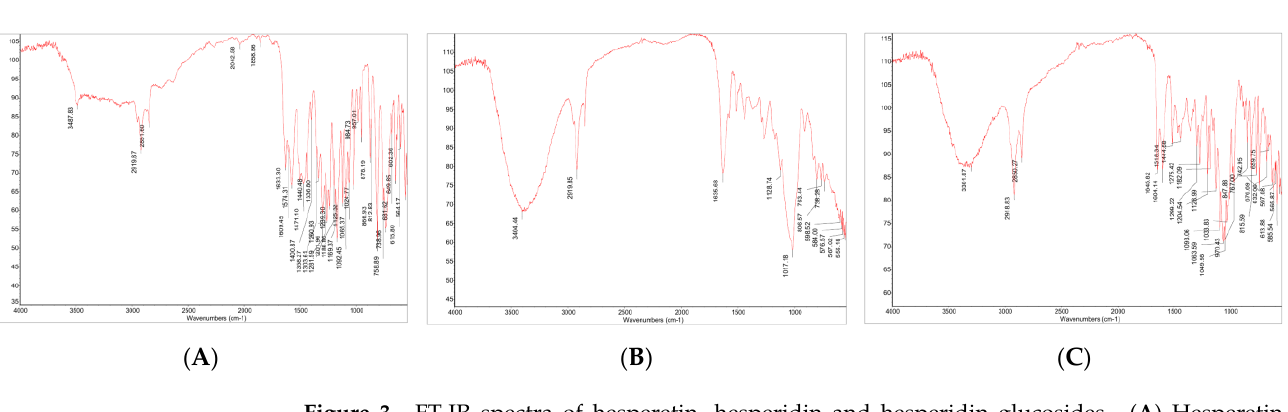
Figure 2. HPLC profiles of hesperidin glucosides synthesized during enzymatic transglycosylation. The x- and y-axis represents the retention time (min) and arbitrary unit (AU), respectively. Abbreviation, HD; hesperidin, HG1; hesperidin mono-glucoside, HG2; hesperidin di-glucoside, HG3; hesperidin tri-glucoside, HG4; hesperidin tetra-glucoside, HG5; hesperidin penta-glucoside.